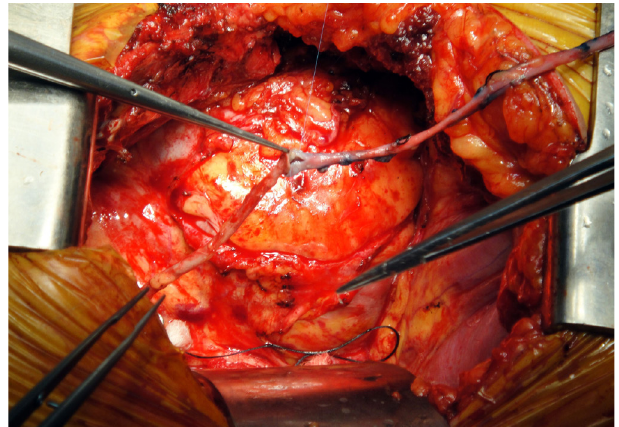
Fig. 2 - Anastomosis RITA-SVG - A small piece of SVG is anastomosed to the RITA with running suture of 8/0 prolene.